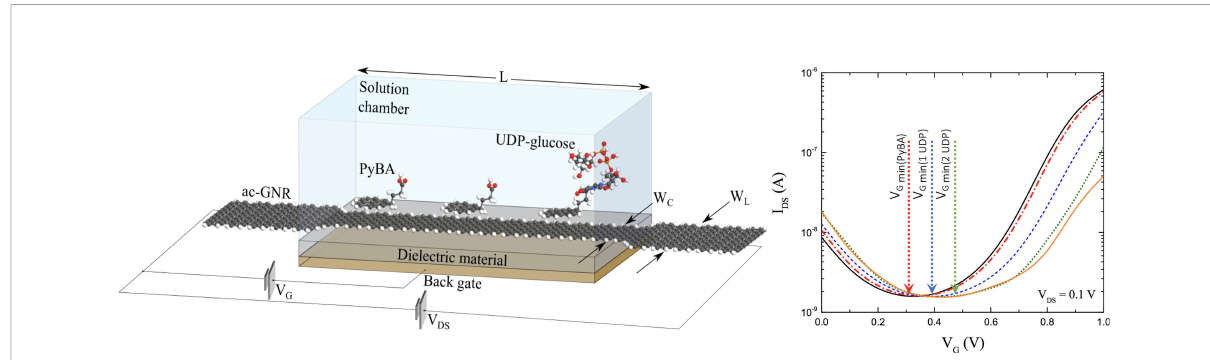
FIGURE 6 (Left) Isometric view of graphene-based FED sensor with solvent box, 3 PyBA SAM molecules, and 1 bound UDP-glucose molecule. A metallic back-gate, with an 8 nm thick separating region with relative dielectric constant of 3.9 (i.e. SiO 2), lay under the semiconducting junction; (right) Transconductance shows p -doping effect of increasing UDP-glucose concentration (at V DS =0.1 V). Figures from (Jaramillo-Botero and Marmolejo-Tejada,